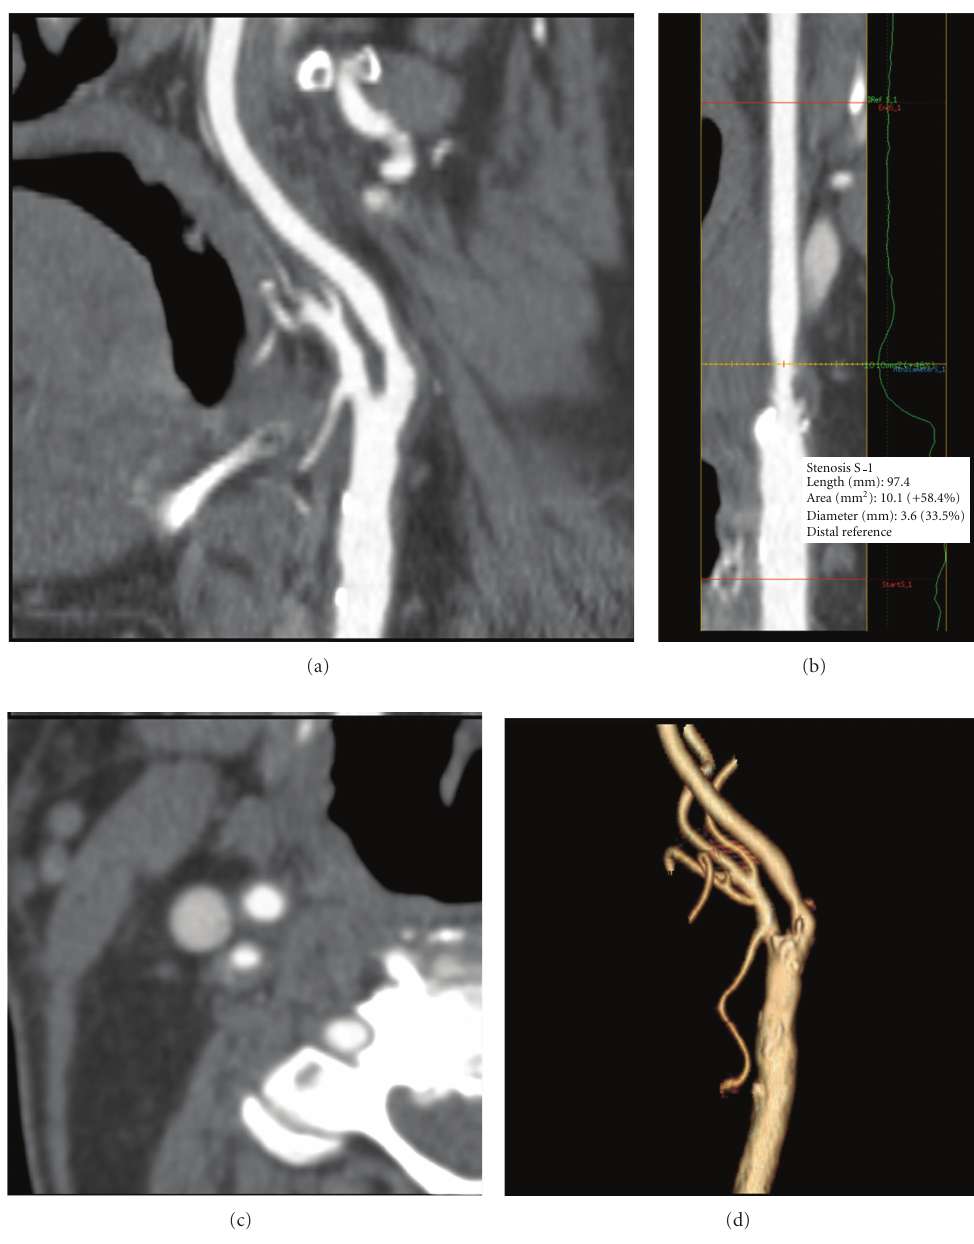
Figure 5: Right carotid stenosis demonstrated on CT angiography (CTA) (Case 2) with curved image (a) and lumen image produced by Advanced Vessel Analysis (AVA) software (b). The curved image shows the plaque. The software analysis defines automatically the level of maximal stenosis. Regular cross-sectional image showing the diameter at the stenosis level (c). In this case the measurements on CTA shows a minimum diameter of 3,6 mm with a 58.4% of stenosis degree. Volume rendering showing the right internal carotid artery